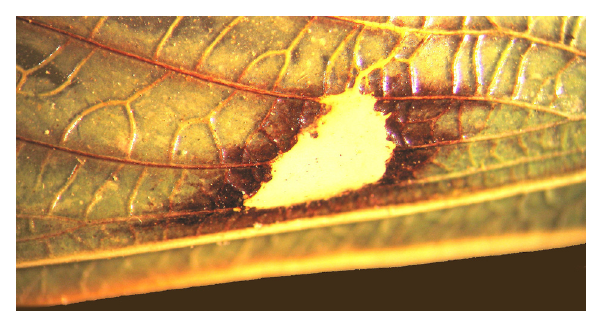
Image 7. Stigma bordered